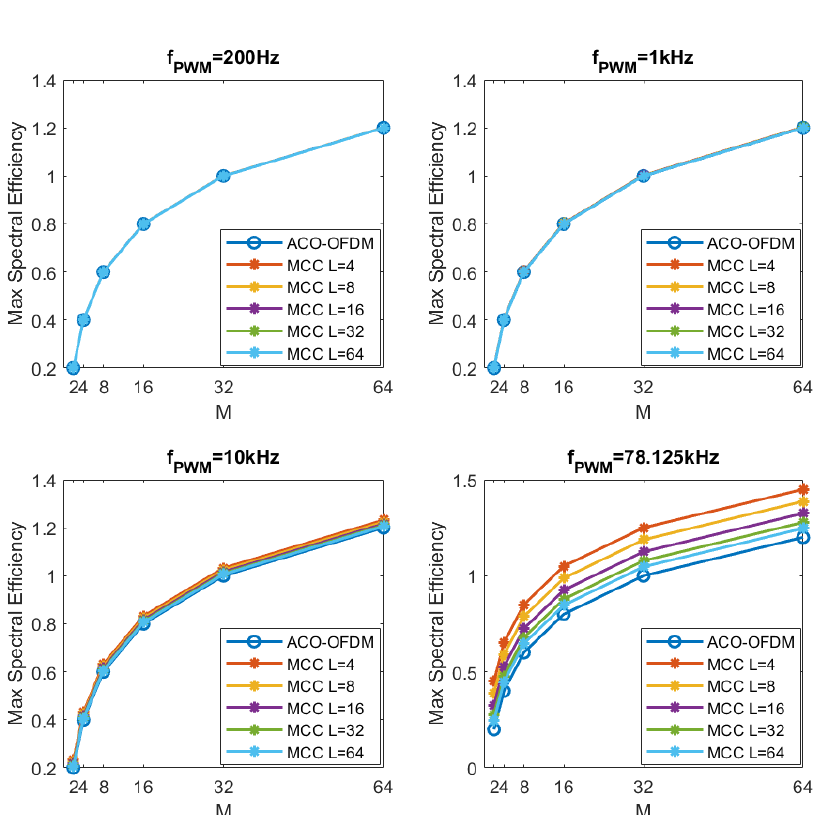
Figure 9. Impact of varying PWM frequency on maximum MCC spectral efficiency at target BER, varying MCC-LS and OFDM QAM modulation